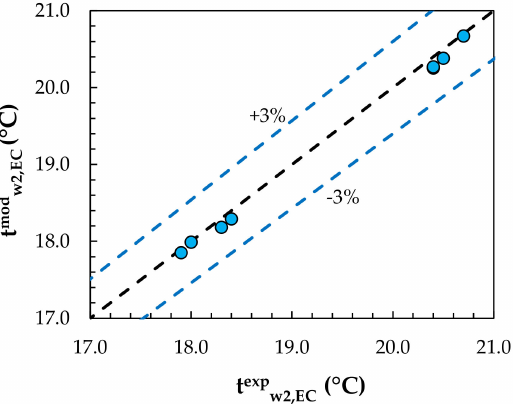
Figure 5. Comparison of model values with experimental results for the water temperature.